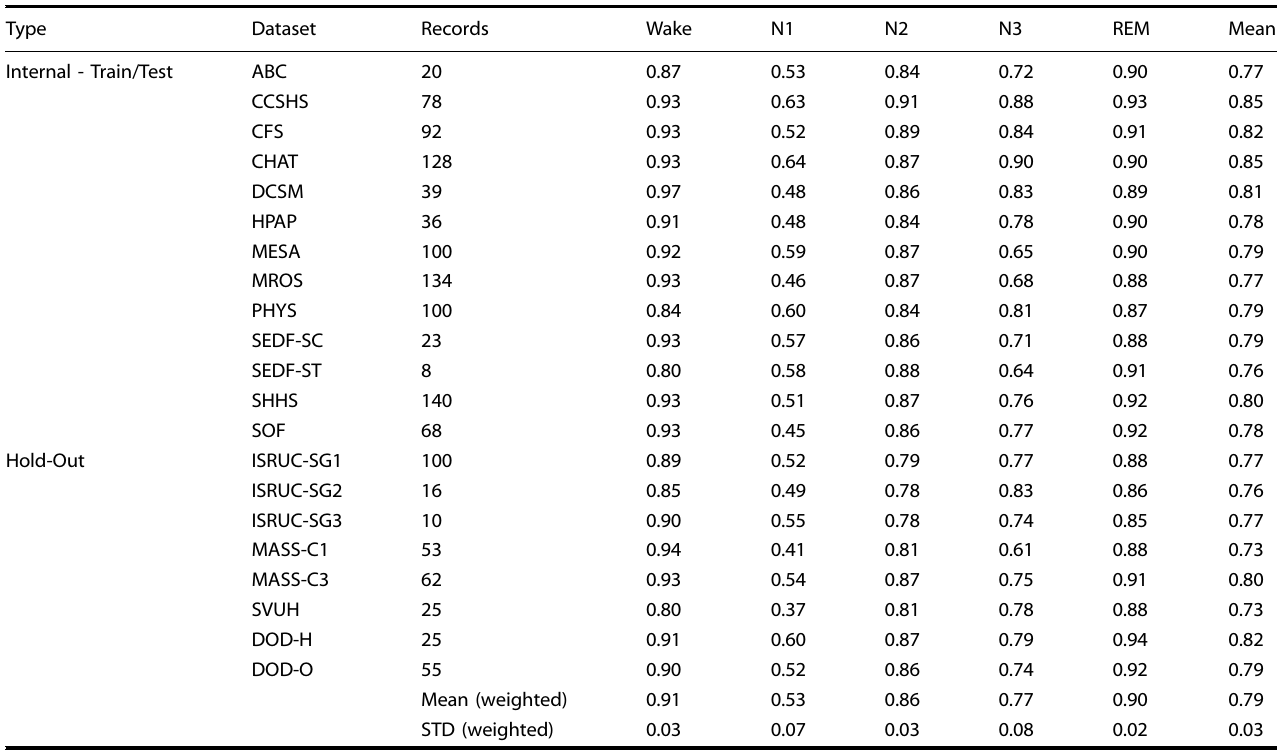
Table 2. Majority vote results